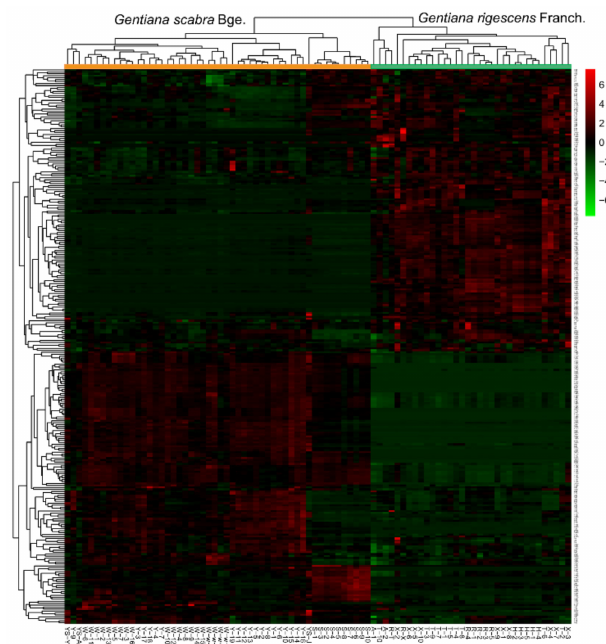
Figure 8. Heat map formed by 283 features ( p -value < 0.05) in Gentiana scabra and Gentiana